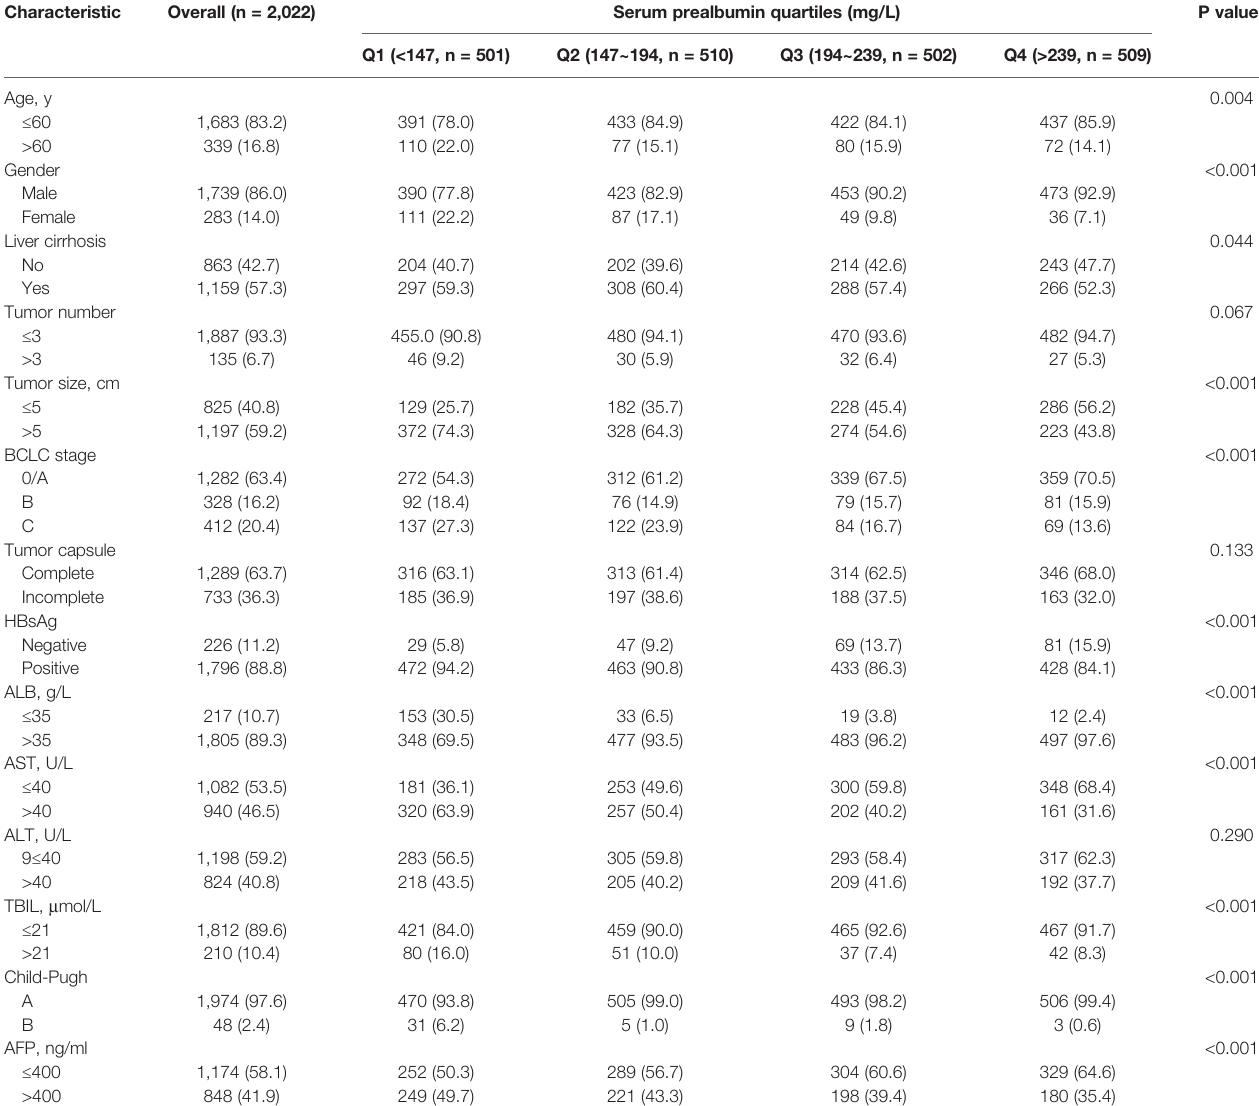
TABLE 1 | Baseline characteristics by serum prealbumin quartiles. Characteristic Overall (n = 2,022) Serum prealbumin quartiles (mg/L) P